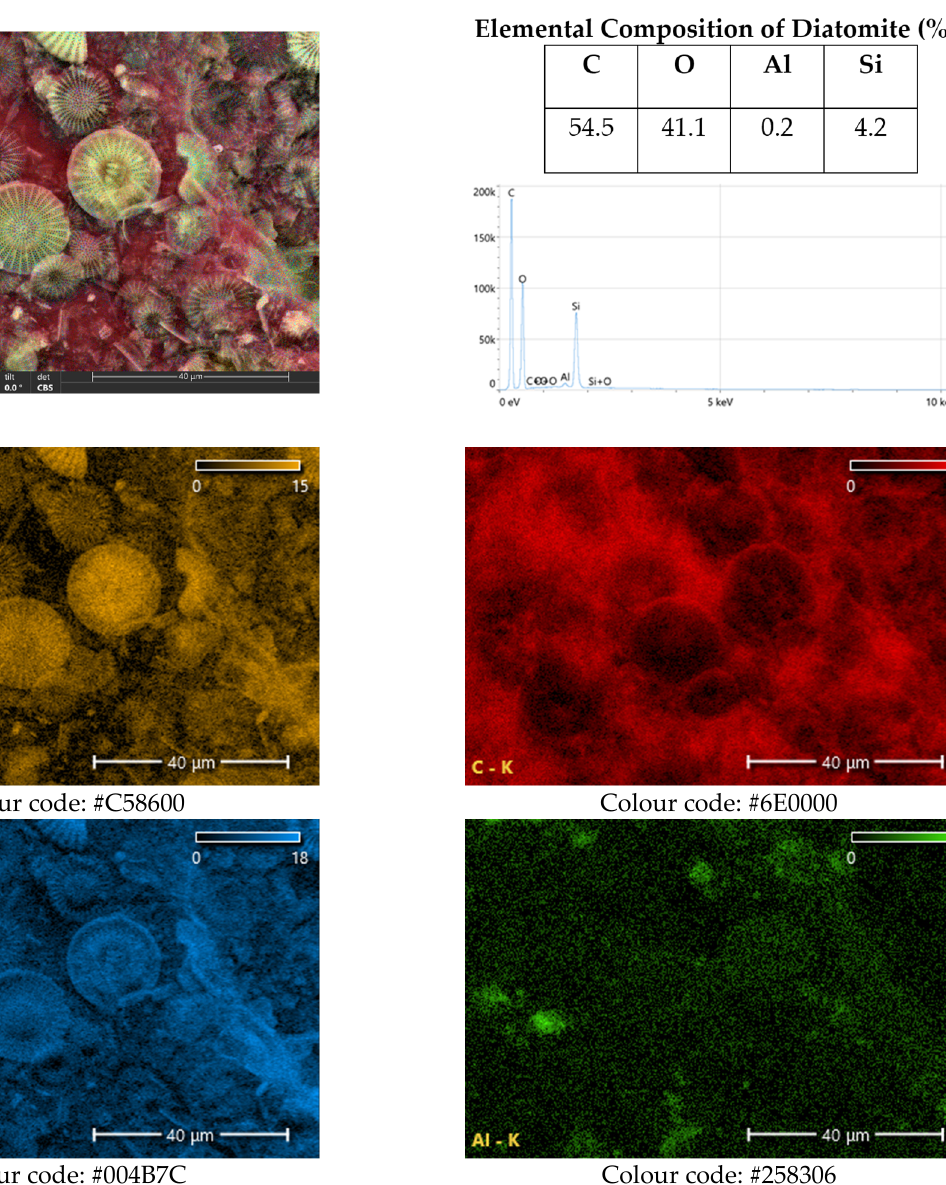
Figure 3. Element maps for diatomite.